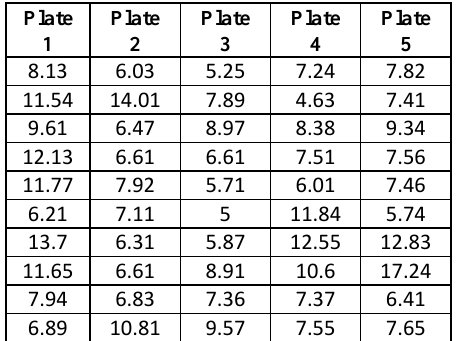
Table 4. The time to read all tags in each